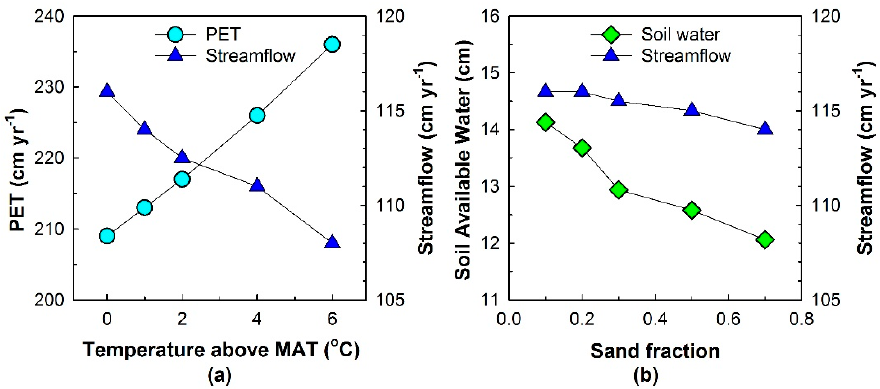
Figure 3. ( a ) Simulated changes in potential evapotranspiration (PET) and streamflow with increasing temperature. ( b ) Simulated changes in soil water available for crop / tree survival and streamflow with changes in soil sand fraction.